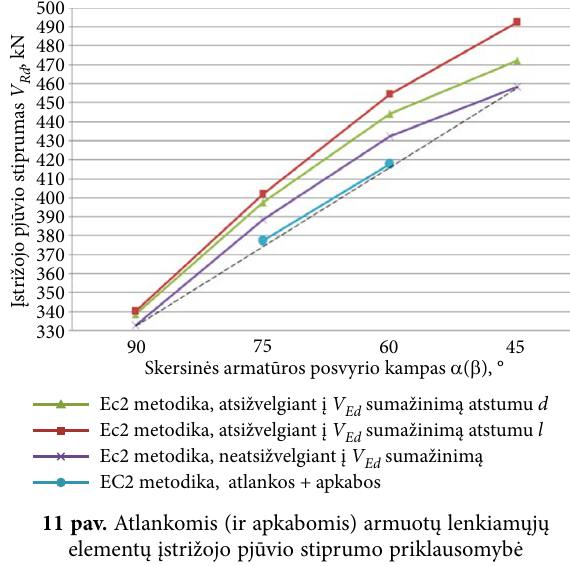
nuo atlankų posvyrio kampo Fig. 11. The relationship between the shear strength of bending elements with shear reinforcement (bends and stirrups) and the bend inclination angle